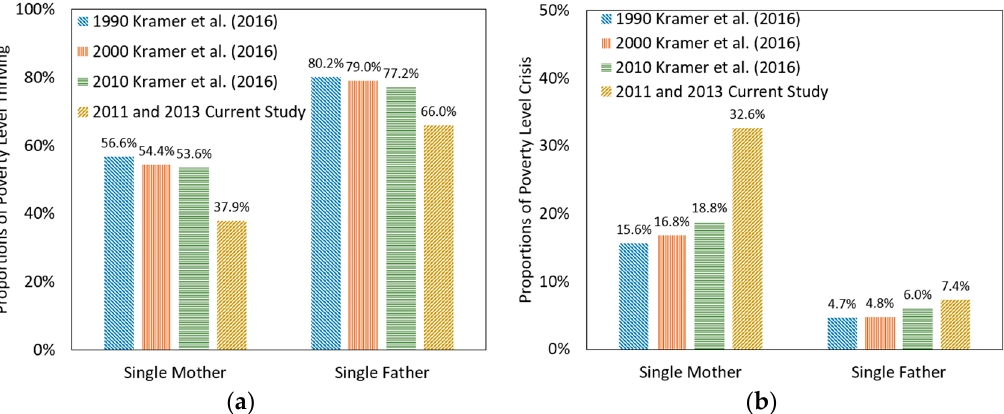
Figure 2. Proportions of single mothers and fathers at ( a ) crisis and ( b ) thriving poverty categories (1990–2013).